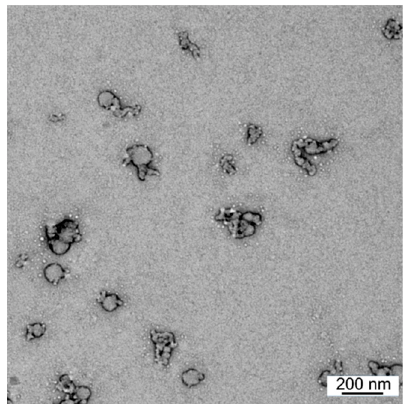
Figure 2. Transmission electron micrograph of PMA-P-J8 stained with 2% uranyl acetate (bar = 200 nm).